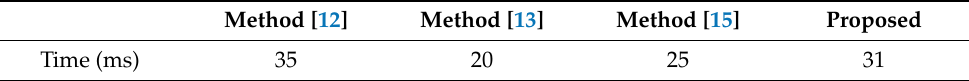
Table 4. Single-frame time consumptions of different video stabilization